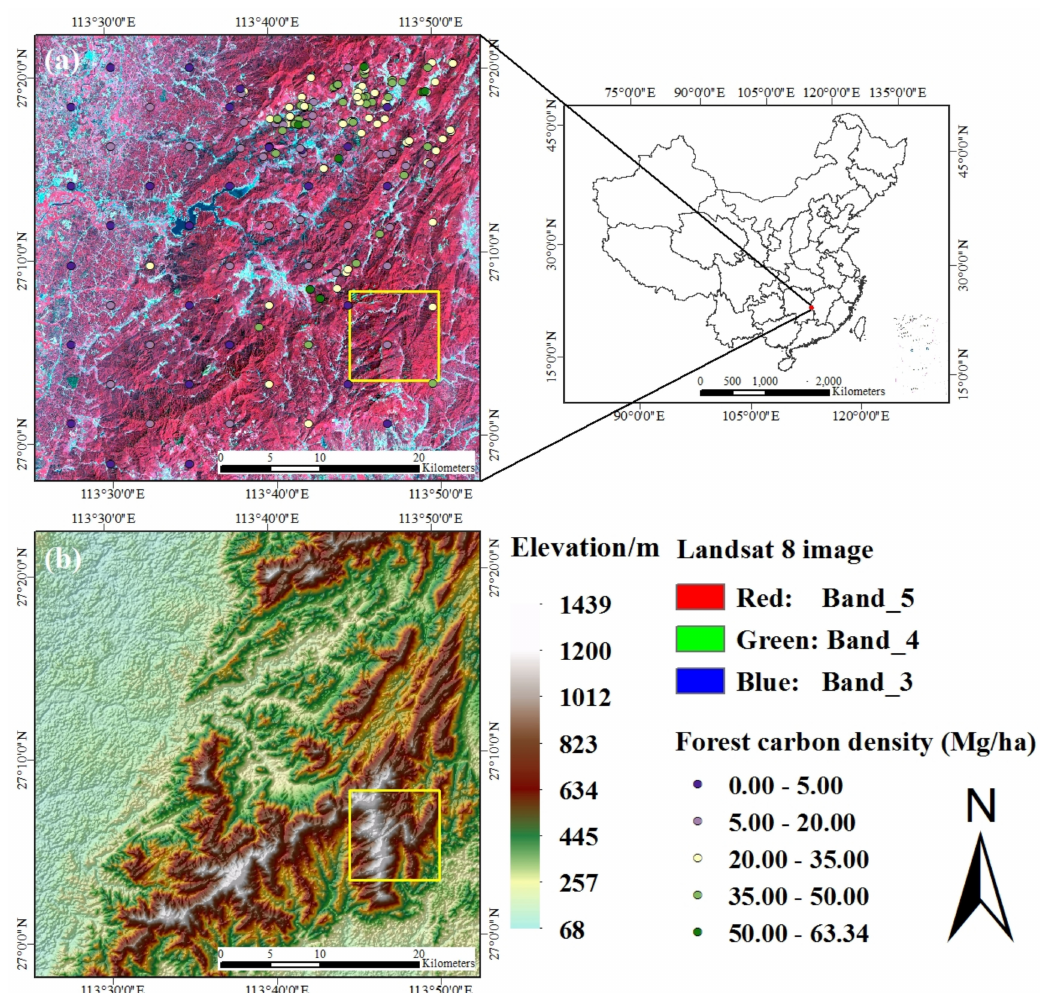
Figure 2. ( a ) Location of the study area shown by a Landsat 8 false-color composite image acquired in September 2013, consisting of RGB represented by Near-Infrared, Red, and Green; ( b ) the topography of the study area. The area outlined by the yellow rectangle is selected for topographic correction analysis in Figure